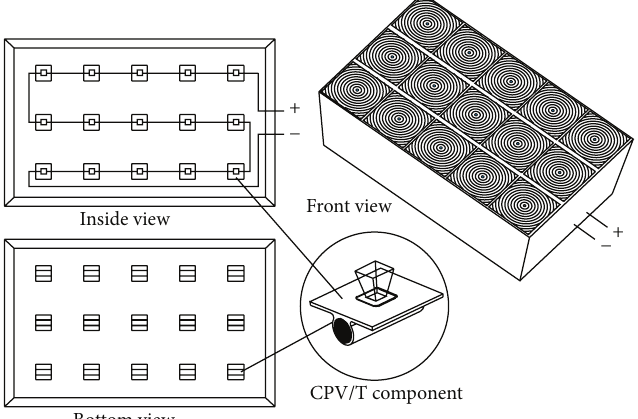
Figure 2: Schematic of the HCPV/T module based on point-focus Fresnel lens.